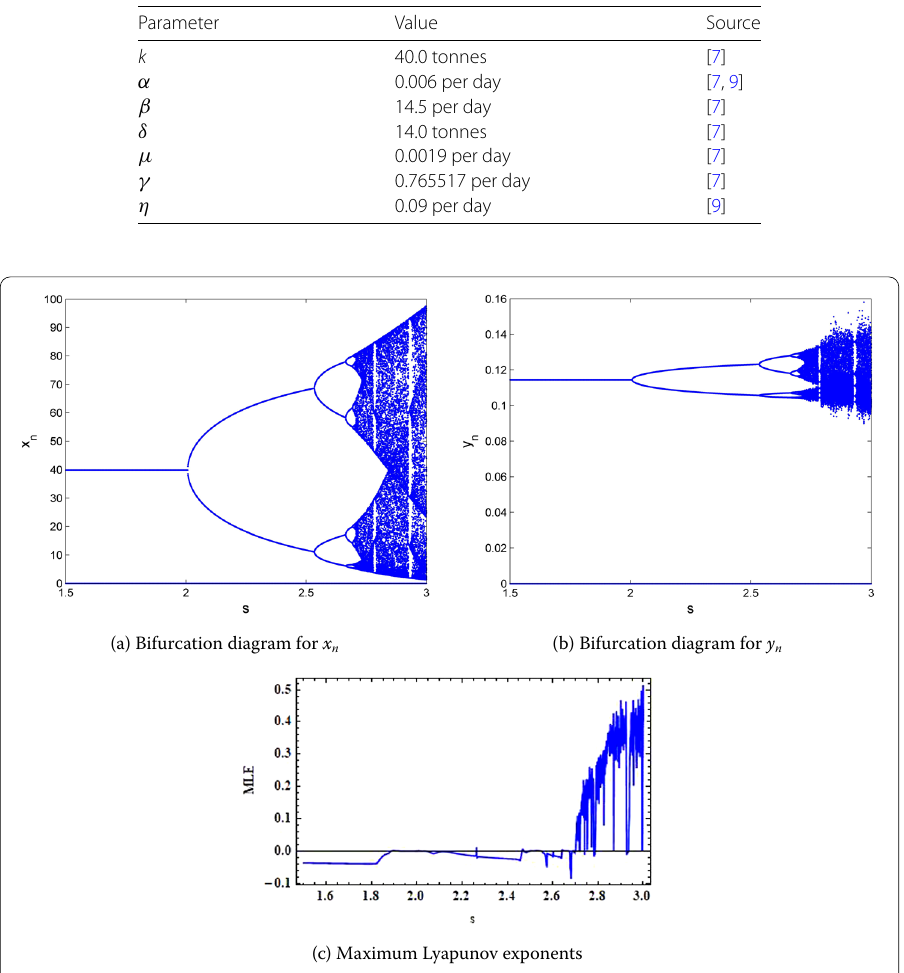
Figure 4 Bifurcation diagrams and MLE for system (1.3) with α = 0.006, k = 40, β = 14.5, δ = 14, μ = 0.0019, γ = 0.765517, η = 0.09, c = 1.2, ( x 0 , y 0 , z 0 ) = (39.8735,0.114441,0.20291) and s ∈